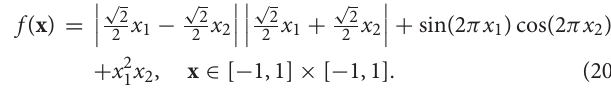
x on the interval [ 1,1]. We used 160 random function samples (using a uniform = | | −